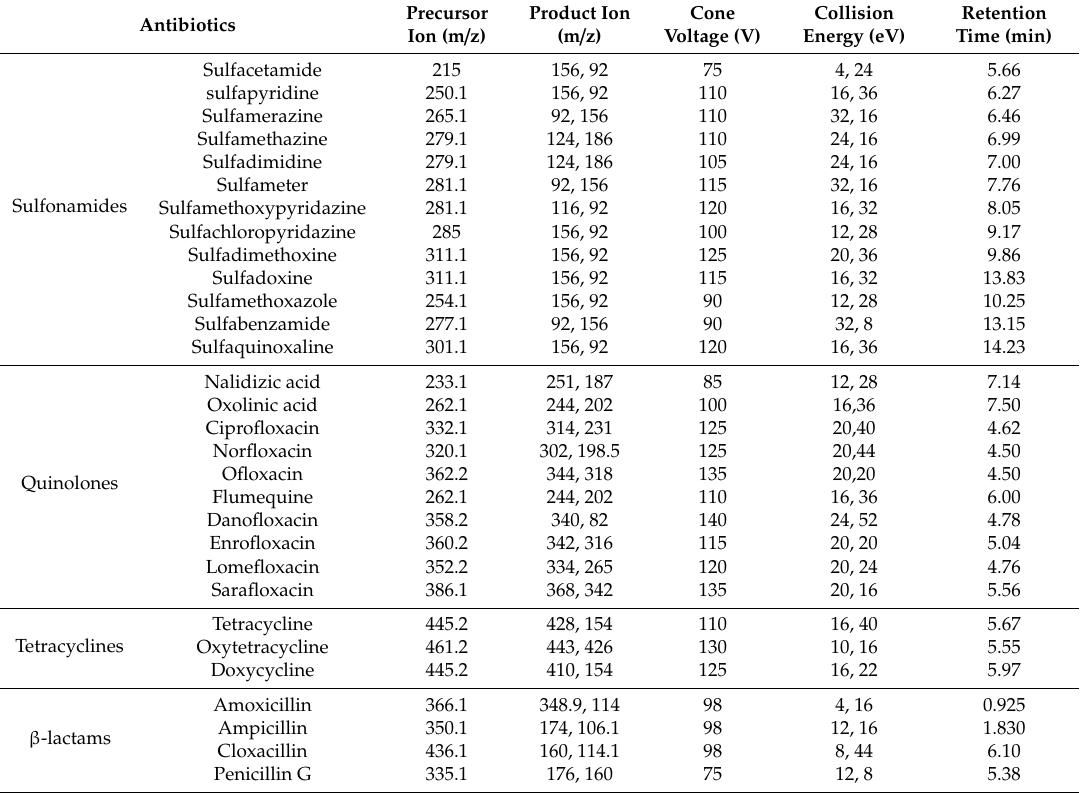
Table 1. Multiple reaction monitoring (MRM) acquisition condition for each antibiotic